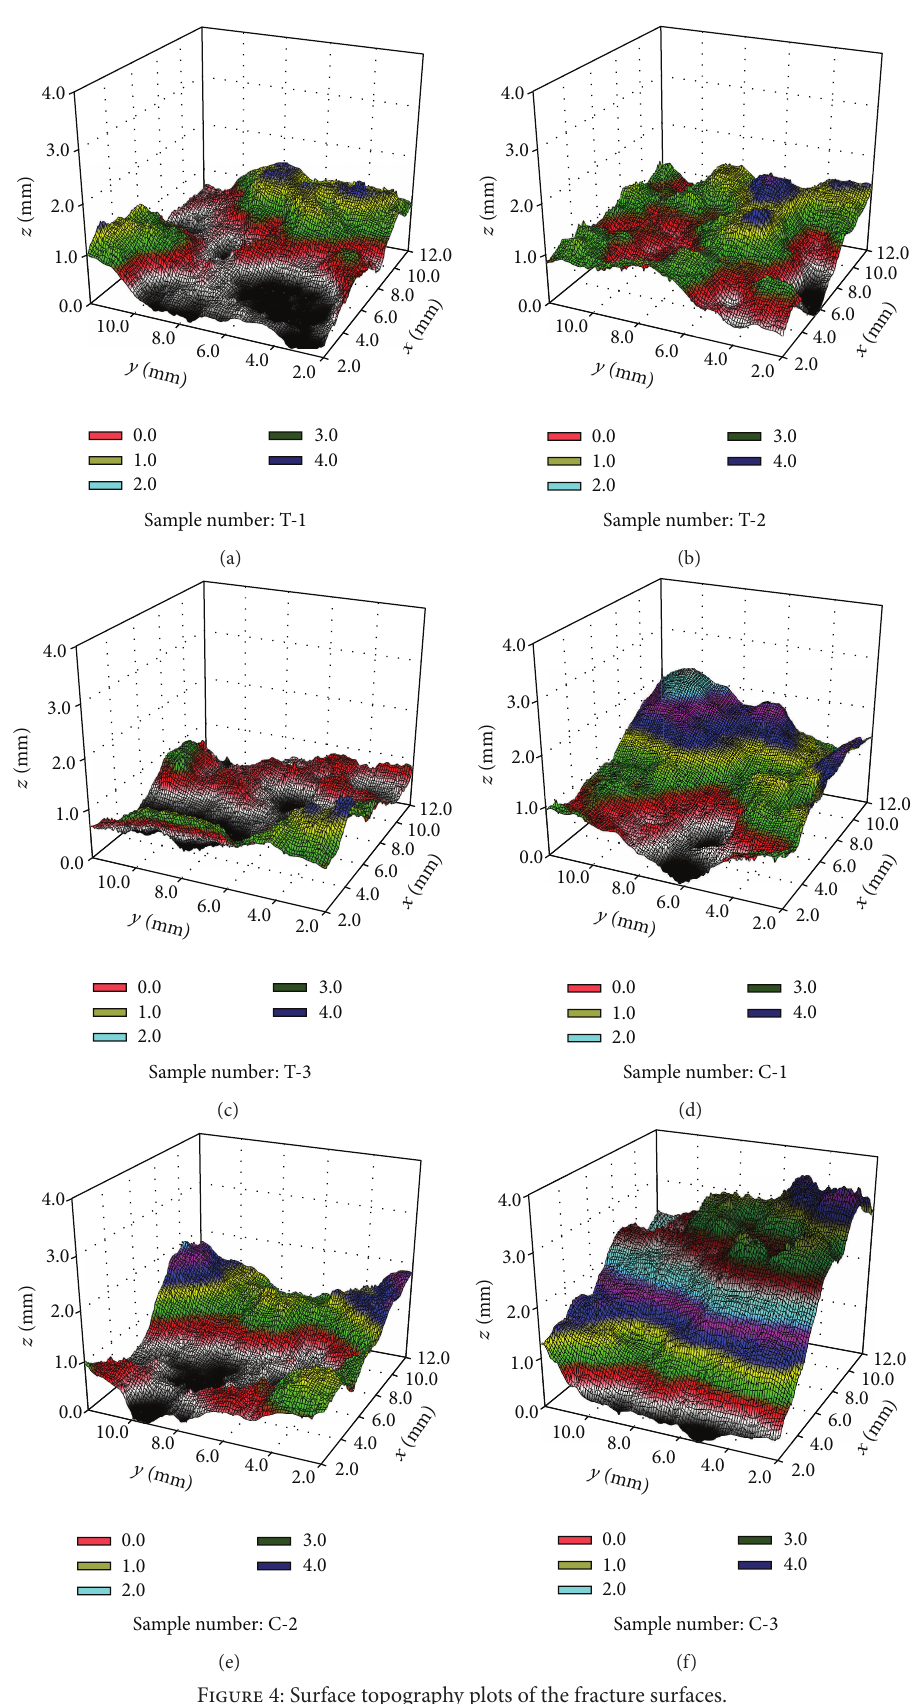
Figure 4: Surface topography plots of the fracture